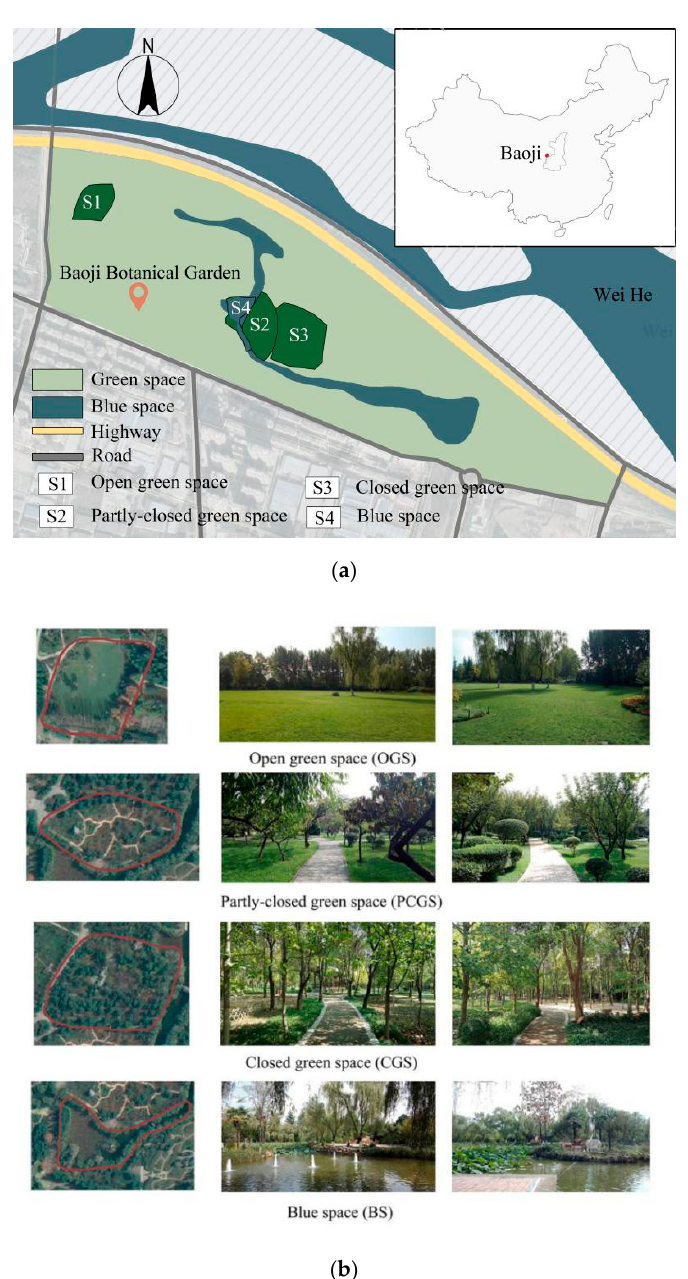
Figure 1. Study area and photographs of the four study sites (OGS: Open green space; PCGS: Partly-closed green space; CGS: Closed green space; BS: Blue space). ( a ) Study area; ( b ) Eight photographs of the four study sites.